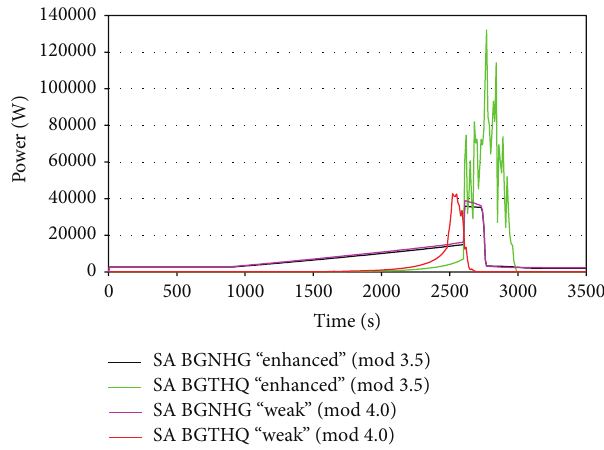
Figure 12: QUENCH-03 test calculation using RELAP/SCDAPSIM mod 4.0 and mod 3.5. The second approach of heat generation in “Cora” description. Total amount of core nuclear heat generation (BGNHG) and core total oxidation heat generation